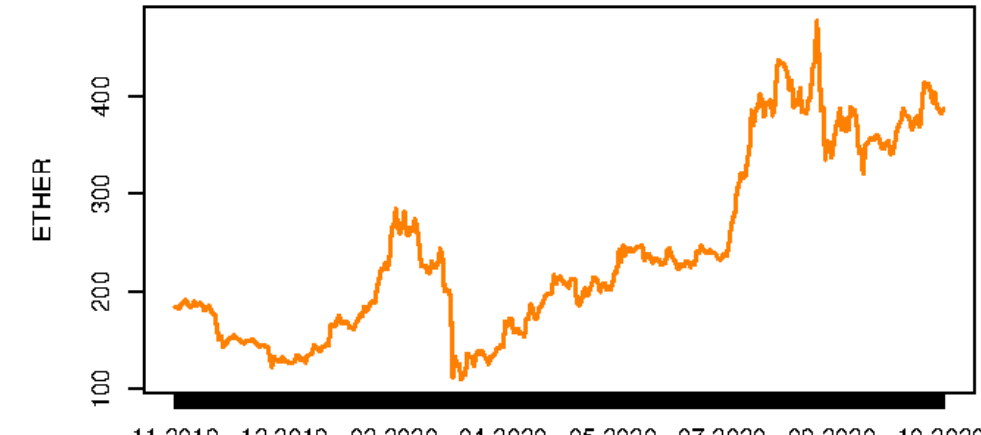
Figure 5. Price of Ethereum